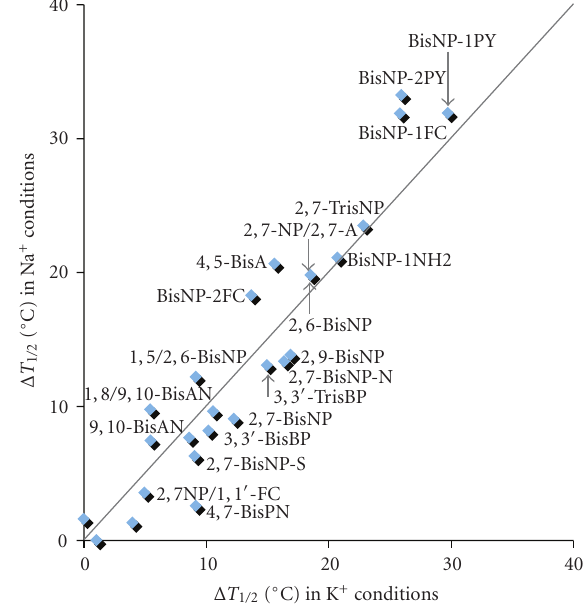
Figure 6: Plot of stabilization ( Δ T 1 / 2 ) measured in K + - versus Na + -rich conditions for the CBI